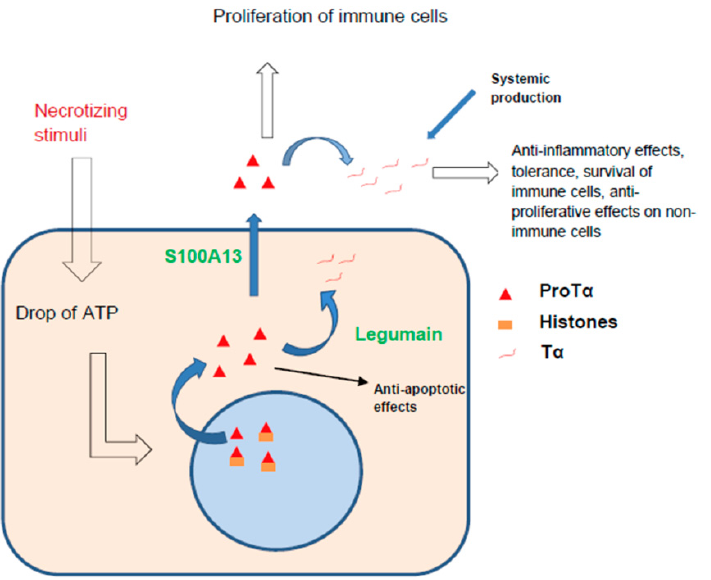
Figure 5. Schematic representation of intracellular and extracellular effects of prothymosin- α (ProT α ) and thymosin- α (T α ). Adapted from our earlier publication